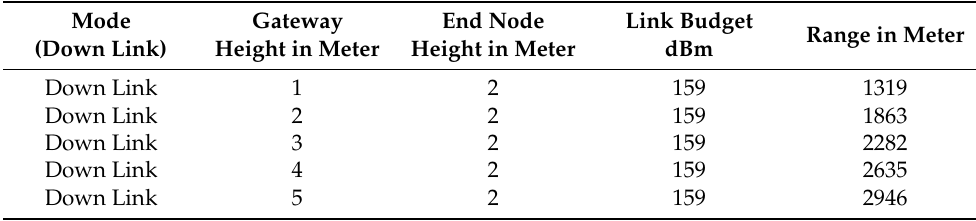
Table 5. Range and link budget at node sensitivity of − 124 dB.